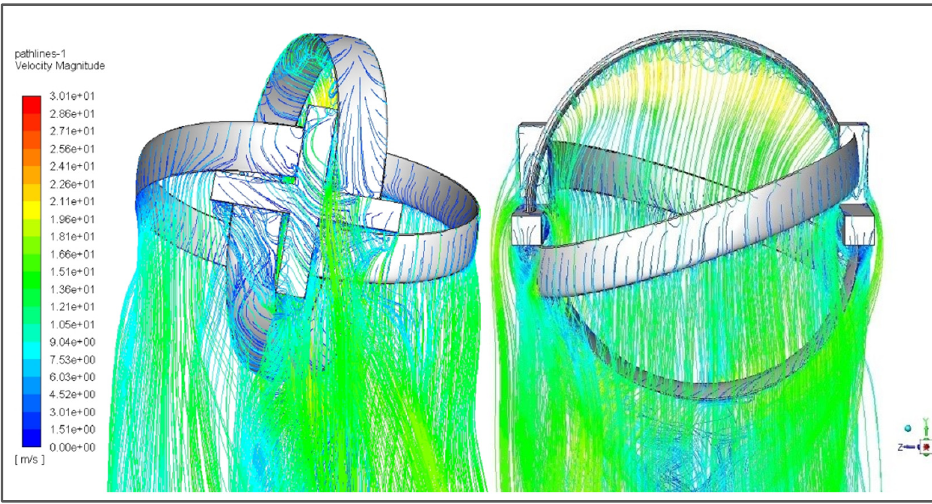
Figure 16. Velocity pathlines of the turbine showing the fluid particle trajectory upon impact with turbine. Velocity contours show velocity measurements translated into average cross-sec- tional flow velocities by contouring the point velocities. In short, they show the change in velocity magnitude with respect to flow behavior. Figure 17 shows the velocity contours of the fluid around the turbine and how its velocity changes after the impact.